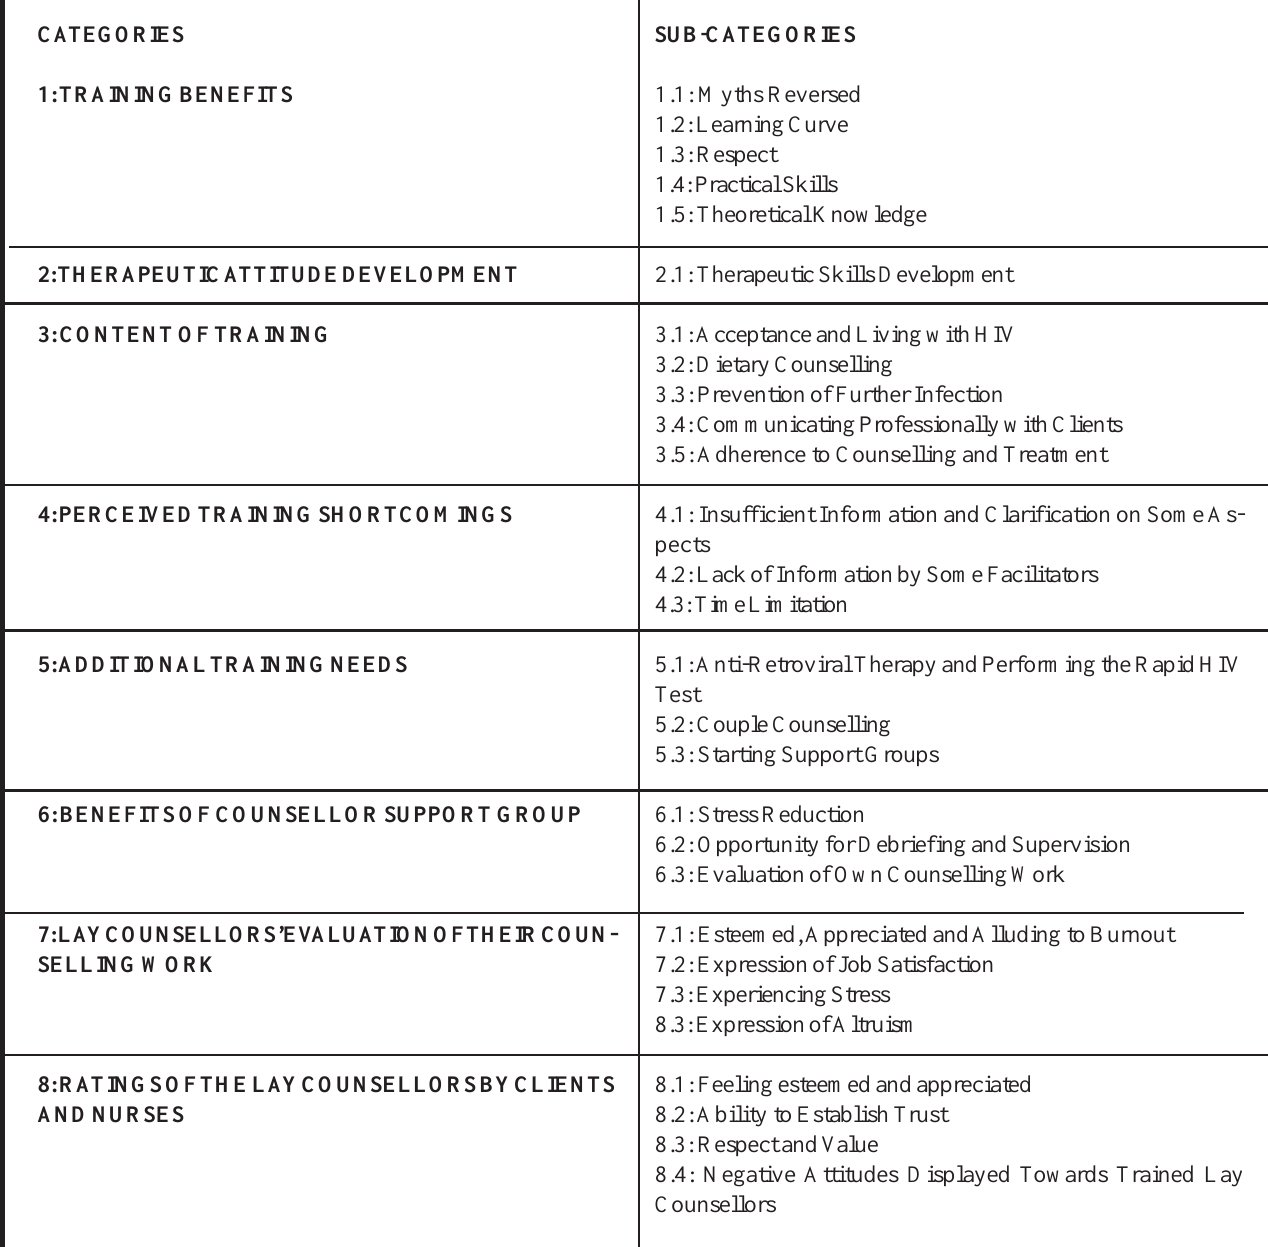
Table 1: Categories and Sub-categories